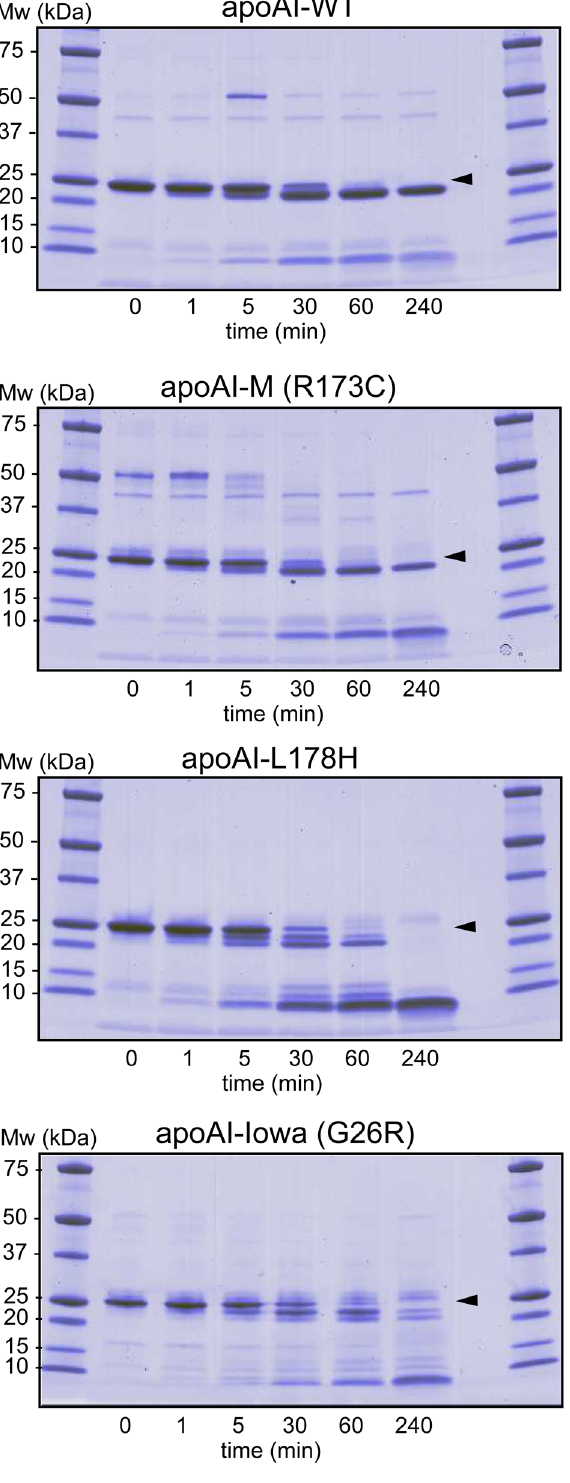
Figure 2. Limited proteolysis of apoA-I proteins to assay for structure accessibility. ApoA-I proteins (0.3 mg/ml) were incubated with chymotrypsin at 37 u C for indicated times followed by SDS-PAGE separation and coomassie staining of the gel. Arrows indicate migration distance of full-length proteins.